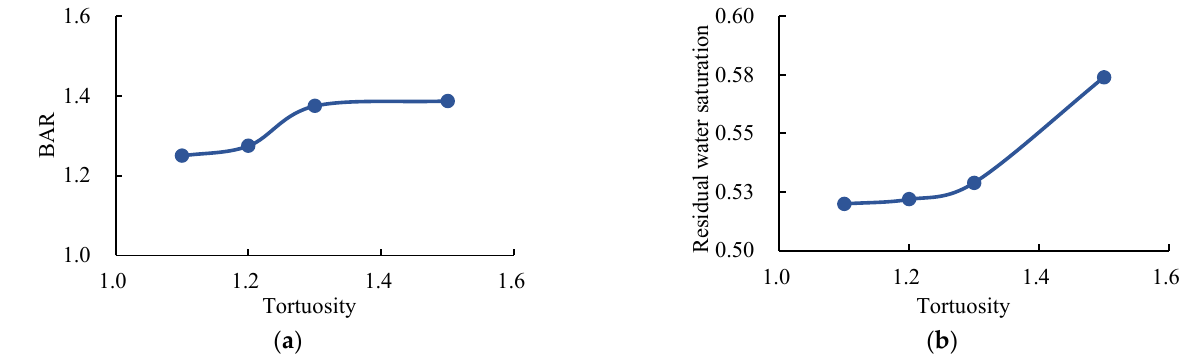
Figure 11. Effect of tortuosity on ( a ) bubble aspect ratio and ( b ) residual water saturation.